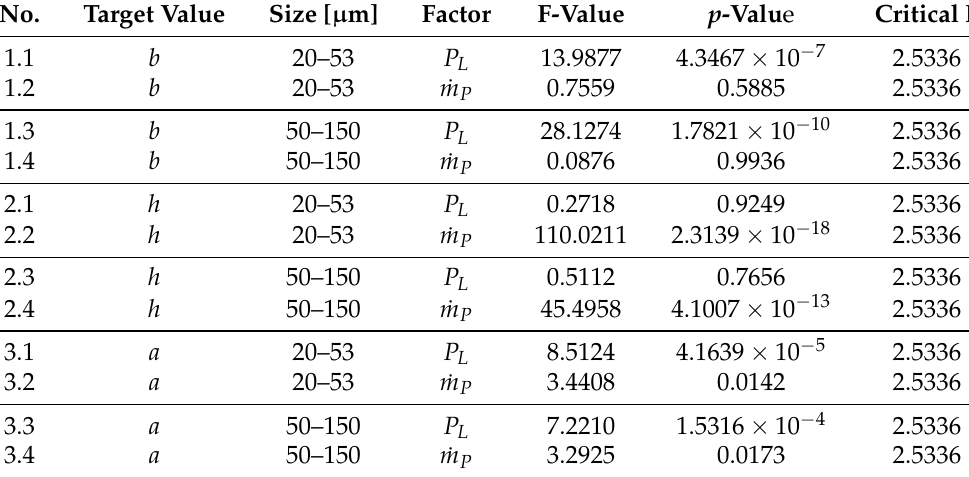
Table A8. Overview of the results of analysis of variance for varying laser power and mass